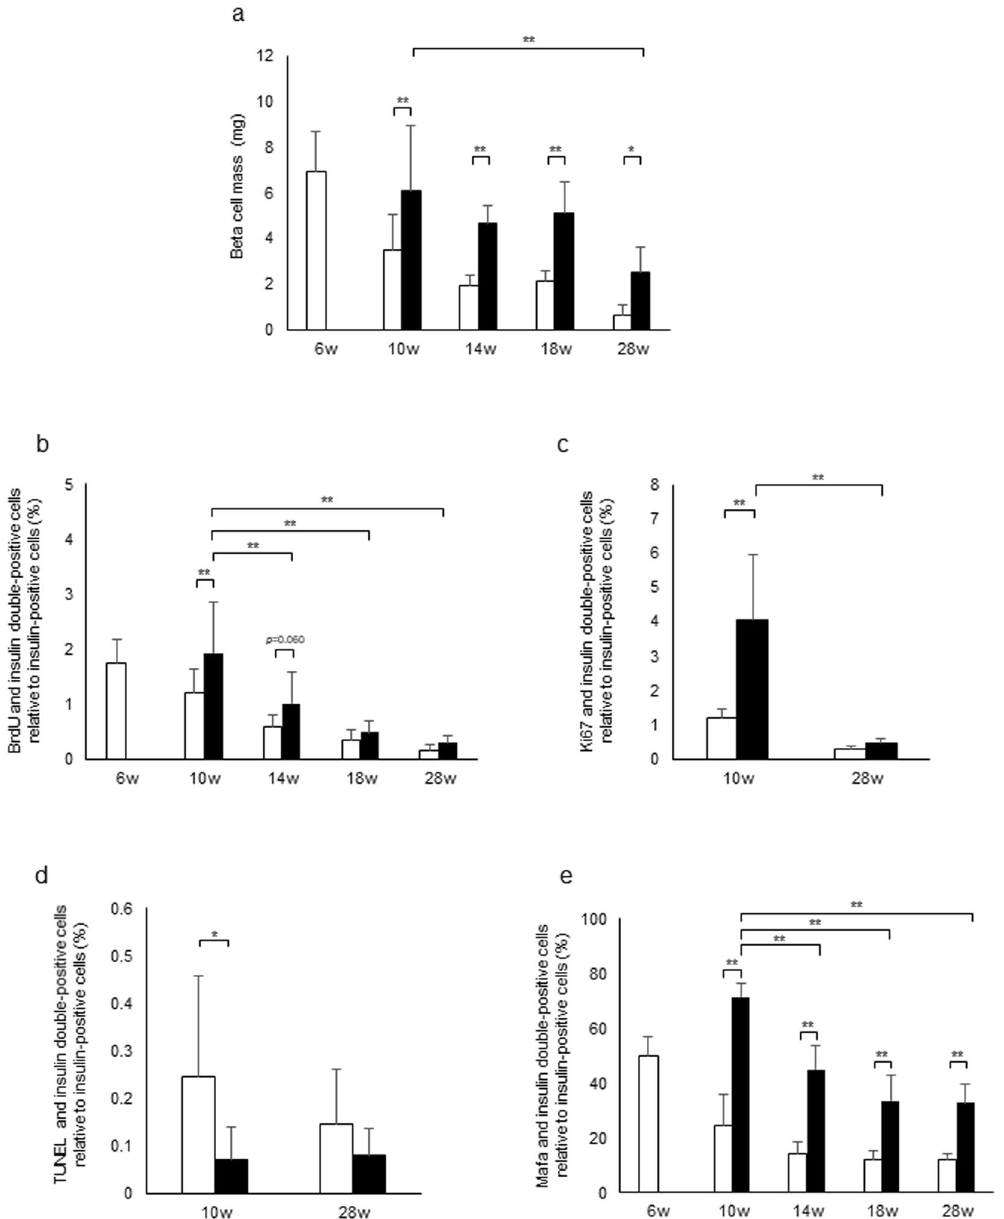
Figure 5. Effects of luseogliflozin on beta cell morphology in db/db mice of different ages. ( a ) Quantitation of beta cell mass in the control group (white bar) and the luseo group (black bar) in 6-, 10-, 14-, 18- and 28-week- old db/db mice ( n = 4–8: 4–8 mice were used in each group). ( b ) Proliferation rate of beta cells assessed using BrdU incorporation in the control group (white bar) and the luseo group (black bar) in 6-, 10-, 14-, 18- and 28-week-old db/db mice ( n = 4–8: 4–8 mice were used in each group). ( c ) Proliferation rate of beta cells evaluated using Ki67 staining in the control group (white bar) and the luseo group (black bar) in 10- and 28-week-old db/db mice ( n = 5: five mice were used in each group). ( d ) Apoptosis rate of beta cells assessed using the TUNEL assay in the control group (white bar) and the luseo group (black bar) in 10- and 28-week-old db/db mice ( n = 6–8: 6–8 mice were used in each group). ( e ) The ratio of the number of Mafa-positive beta cells relative to the total number of beta cells in the control group (white bar) and the luseo group (black bar) in 6-, 10-, 14-, 18- and 28-week-old db/db mice ( n = 4: four mice were used in each group). Values are mean ± SD. * p < 0.05; ** p <